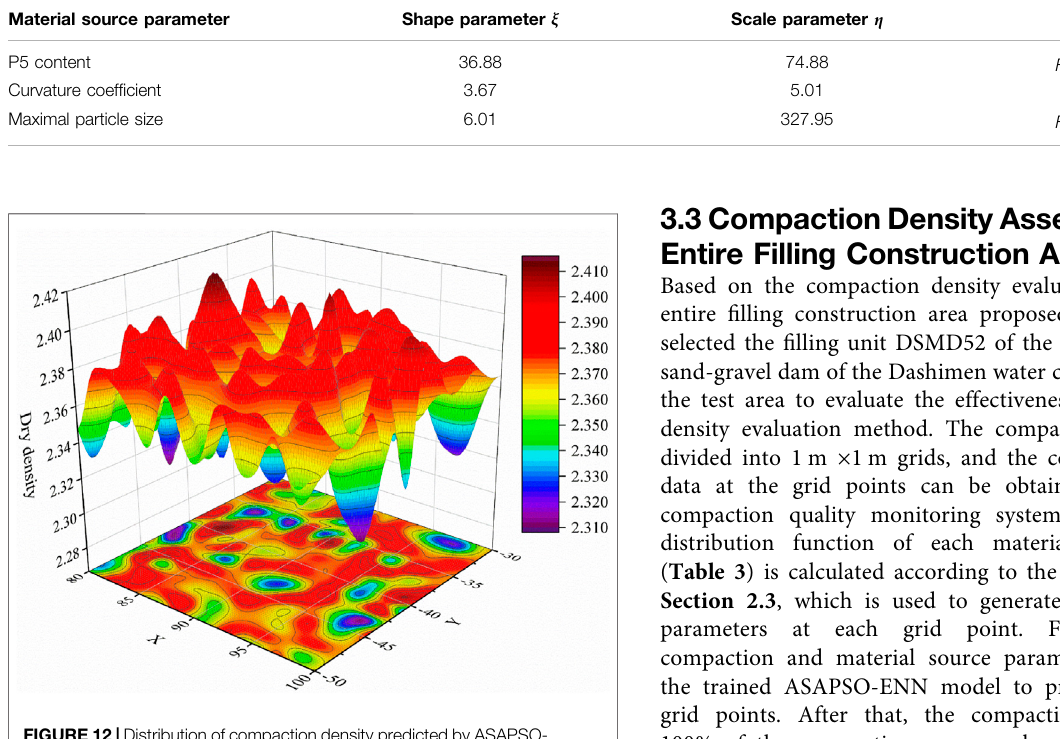
FIGURE 12 | Distribution of compaction density predicted by ASAPSO- ENN